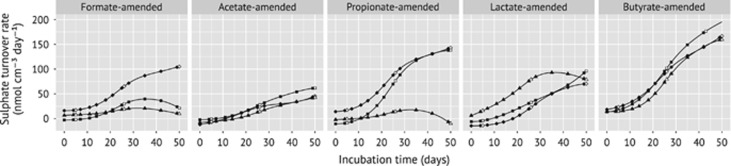
Substrate-specific net ST rates in sulfate-stimulated microcosm. Individual microcosms are depicted by different symbols (and are consistent in all figures that show triplicate data). Solid symbols indicate time points where sulfate concentrations were measured, and open symbols indicate time points selected for 16S rRNA (gene) amplicon sequencing. Minor negative values are because of variations caused by manual sulfate addition to individual microcosms in comparison with the corresponding no-substrate controls and as such can be neglected. Sulfate pools were never depleted in any sulfate-amended microcosm.